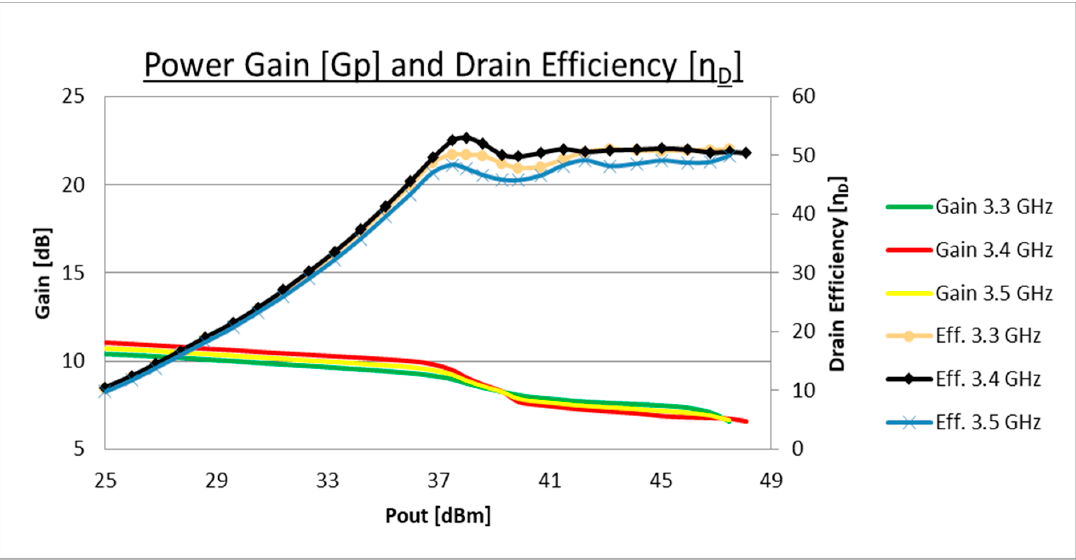
Figure 12. Measured performance of the designed Doherty amplifier.